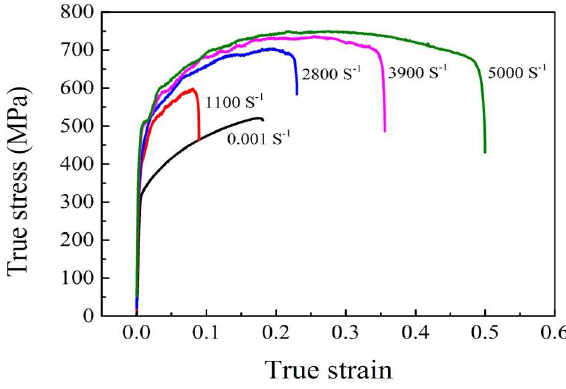
Figure 1. True stress–strain of 2A12-T4 alloy at various strain rates.